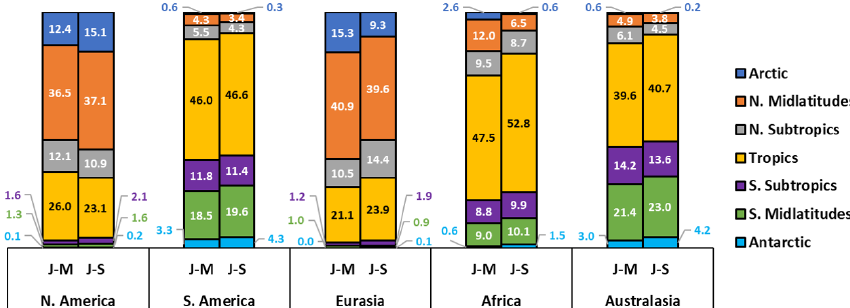
Figure 8. Distribution of residence times in days of 1400 Lagrangian trajectories per emission region and per time period throughout the course of a 90d path. “J–M” is the period January–March 2014 and “J–S” the period July–September 2014. The latitudinal bands are based on Najibi and Devineni (2018) and are defined as Arctic = [65, 90 ◦ N], N. Midlatitudes = [35, 65 ◦ N), N. Subtropics = [23.5, 35 ◦ N), Tropics = [23.5 ◦ S, 23.5 ◦ N), S. Subtropics = [35, 23.5 ◦ S), S. Midlatitudes = [65, 35 ◦ S) and Antarctic = [90, 65 ◦ S).